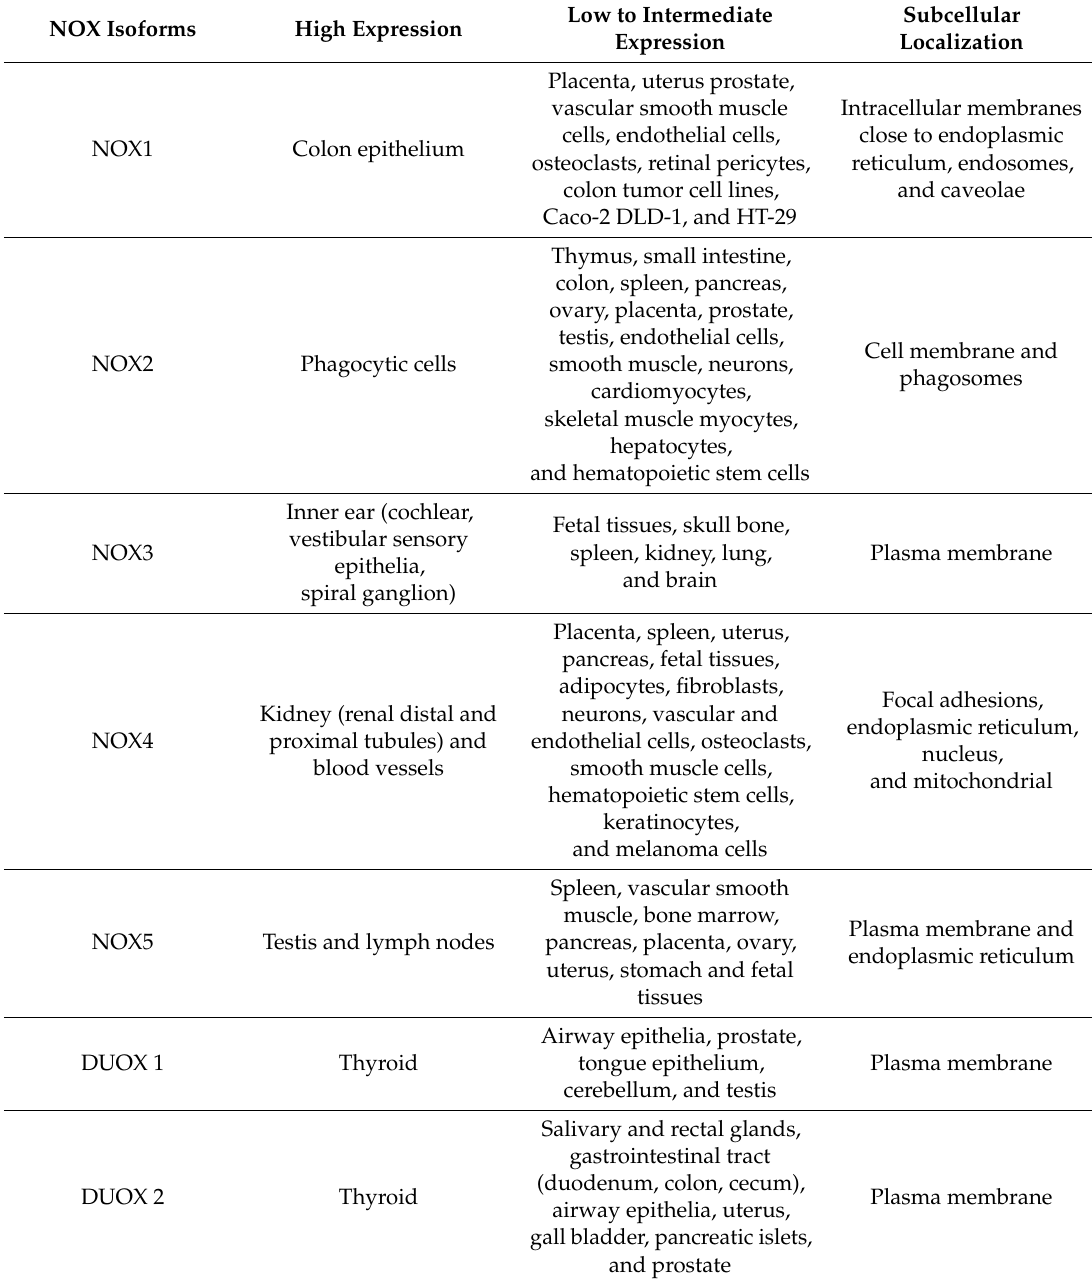
Table 1. Tissue distribution and subcellular localization of NOX